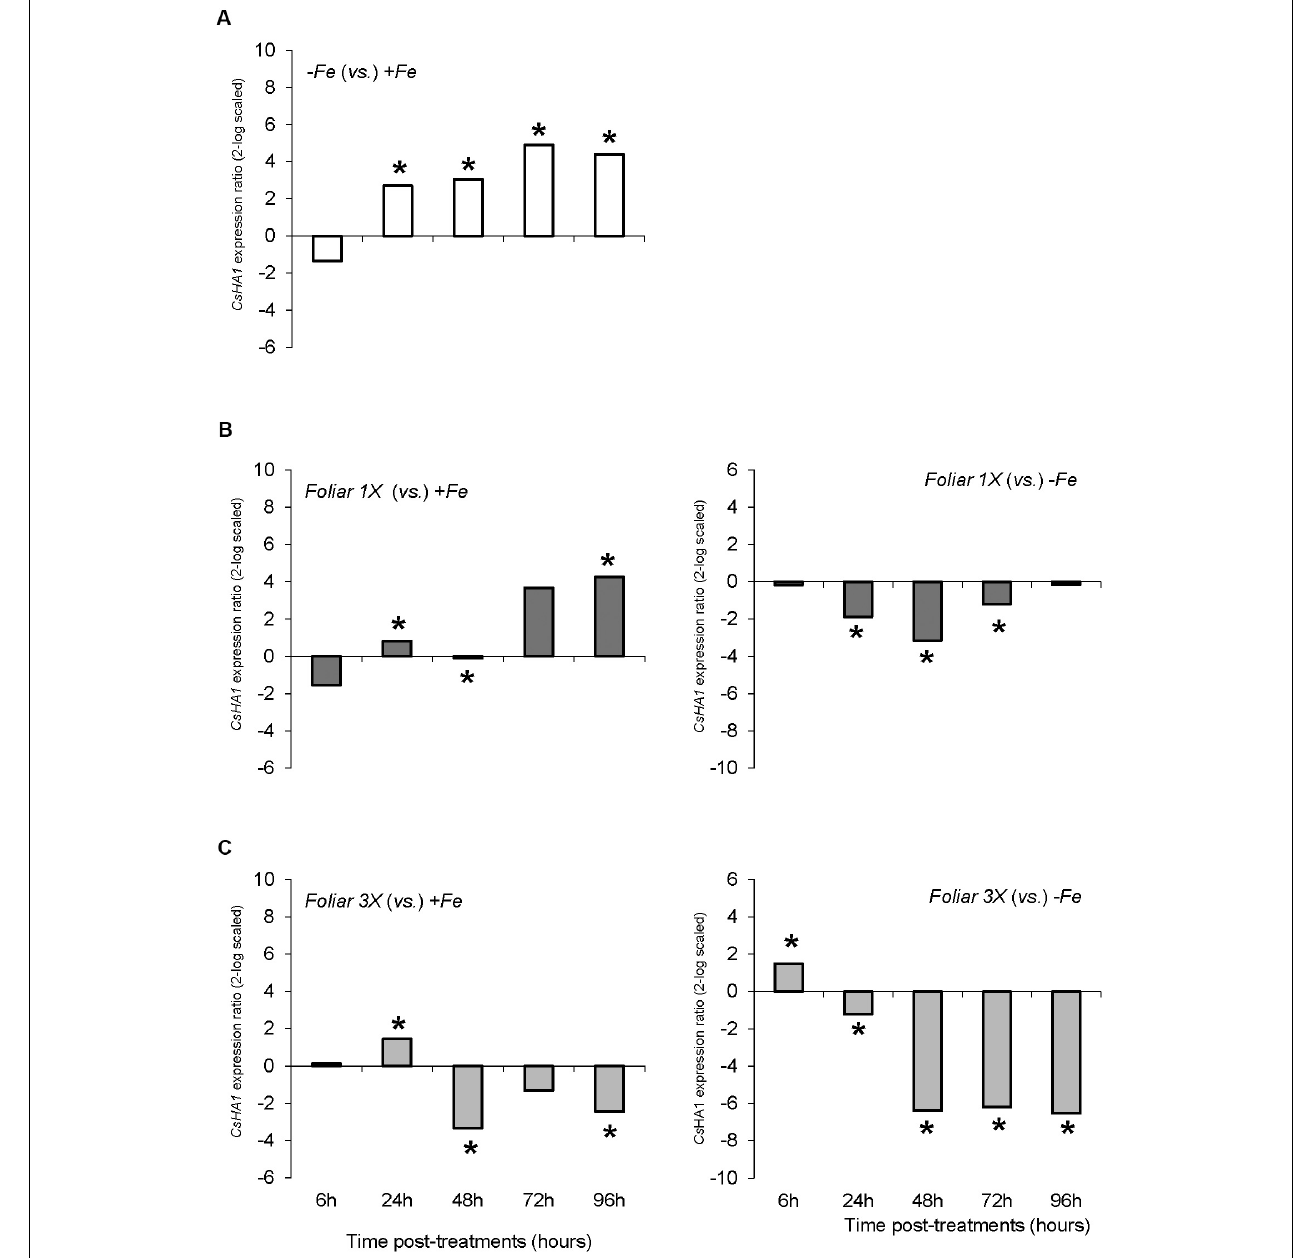
FIGURE 5 | CsHA1 expression results in cucumber roots from Experiment I. Plants were grown in a nutrient solution with 5 µ M Fe, and then some of them were transferred to nutrient solutions with 40 µ M Fe (+ Fe ). The rest were transferred to nutrient solutions without Fe (– Fe ). A third of the – Fe plants were sprayed with a single dose of 9 mM FeSO 4 (2.54 mg Fe/plant, Foliar 1X ), and other third was sprayed during 3 consecutive days with 3 mM FeSO 4 (each plant received a total amount of 2.54 mg Fe/plant, Foliar 3X ). (A) Expression of CsHA1 in root of – Fe plants versus + Fe plants. (B ) Expression of CsHA1 in root of Foliar 1X plants versus + Fe (left) and – Fe (right) plants. (C) Expression of CsHA1 in root of Foliar 3X plants versus + Fe (left) and – Fe (right) plants. Data are means ± SE ( n = 5). Asterisks indicate significant differences between treatments at P < 0.05 based on one-way ANOVA and Fisher’s post hoc test. Statistical analysis of relative gene expression results was assessed using P-pairwise fixed reallocation randomization